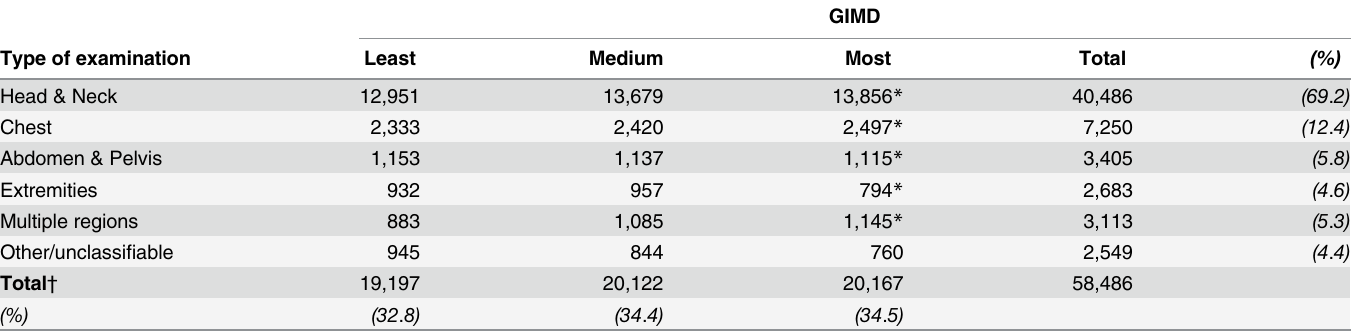
Table 2. Number of CT examinations by GIMD and type of examination in patients under 15 years of age in Germany, 2001 –